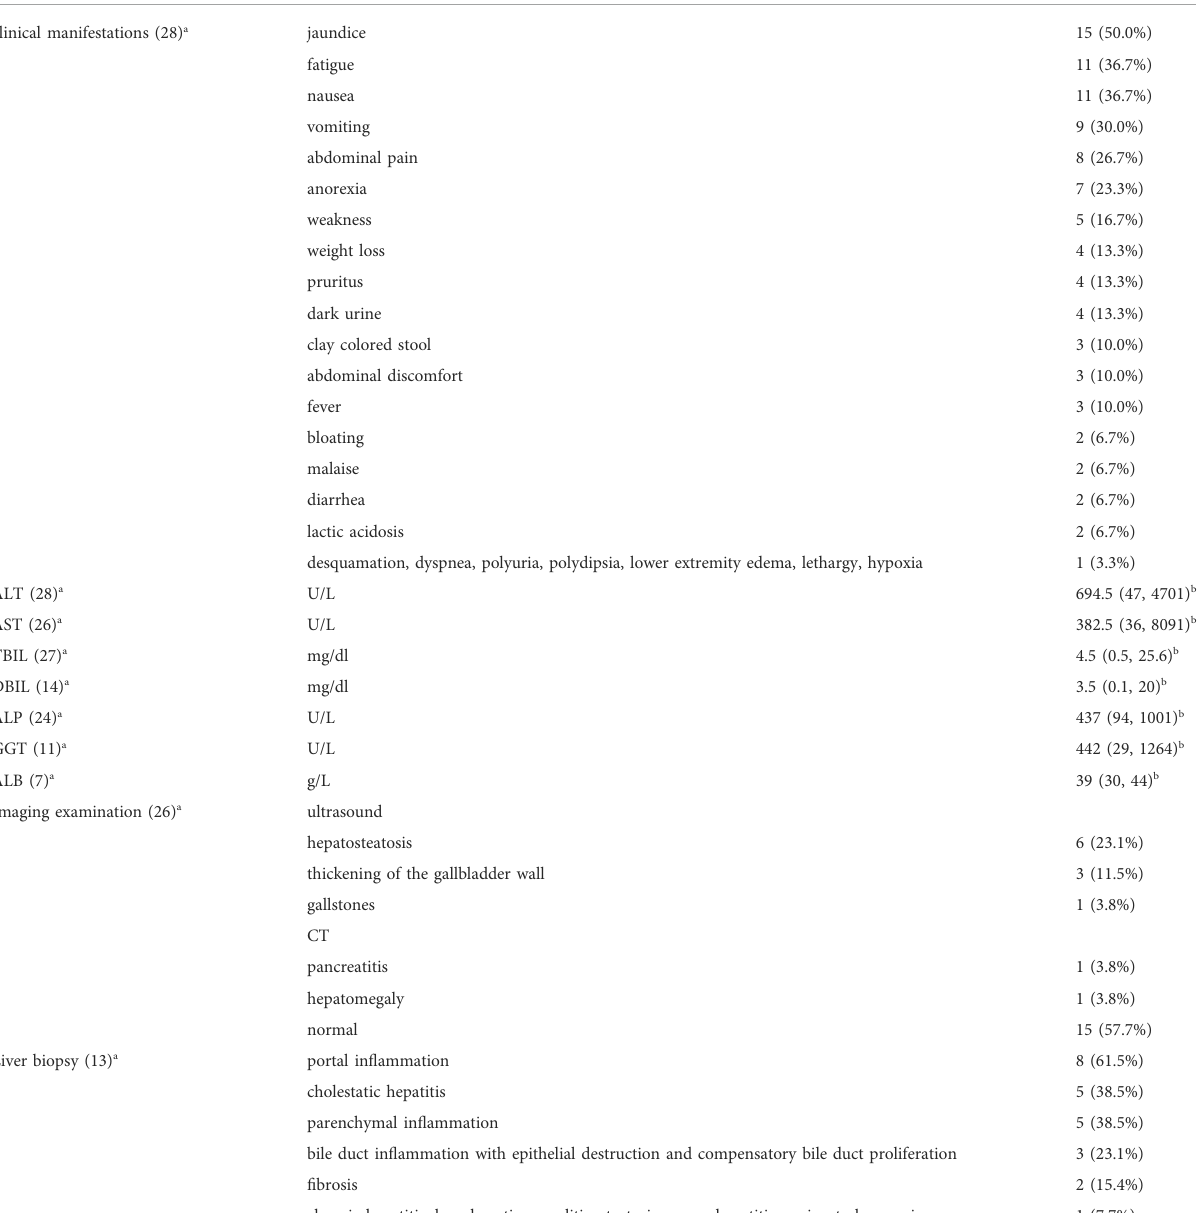
TABLE 3 Clinical manifestations and laboratory tests of 30 patients with metformin-induced hepatotoxicity.